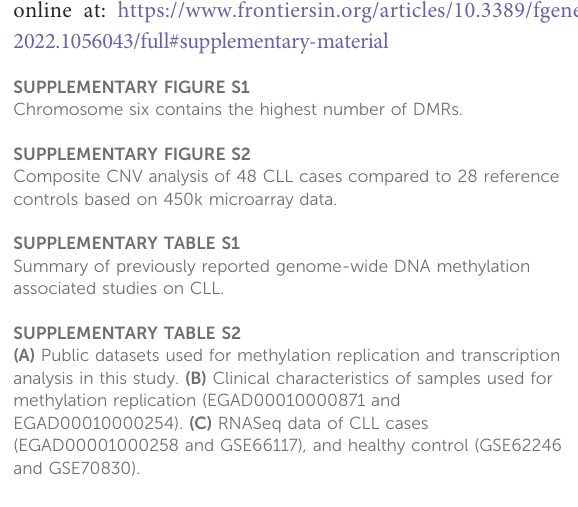
SUPPLEMENTARY FIGURE S2 Composite CNV analysis of 48 CLL cases compared to 28 reference controls based on 450k microarray